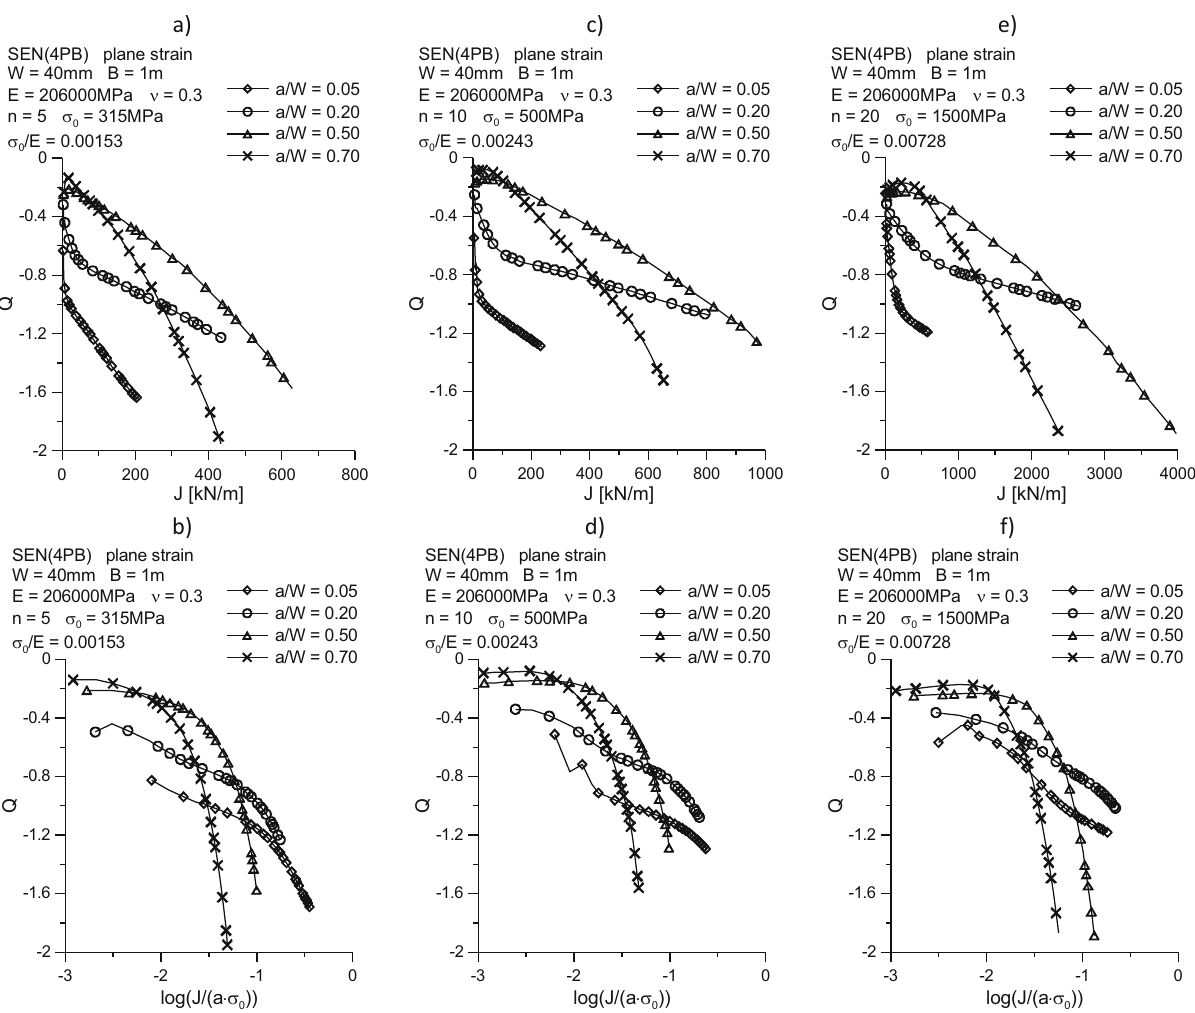
Figure 24: In fl uence of the relative crack length a / W on the distribution of the Q = f ( J ) and Q = f ( log ( J / ( a · σ 0 ))) curves for SEN ( 4PB ) specimen dominated by the plane strain state: ( a and b ) n = 5, σ 0 = 315 MPa; ( c and d ) n = 10, σ 0 = 500 MPa; ( e and f ) n = 20, σ 0 = 1,500